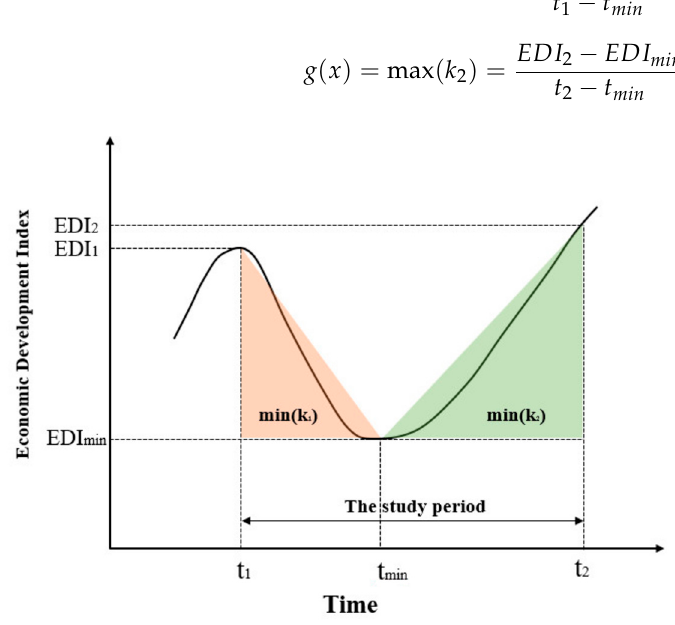
Figure 4. Conceptual Diagram of Economic Resilience